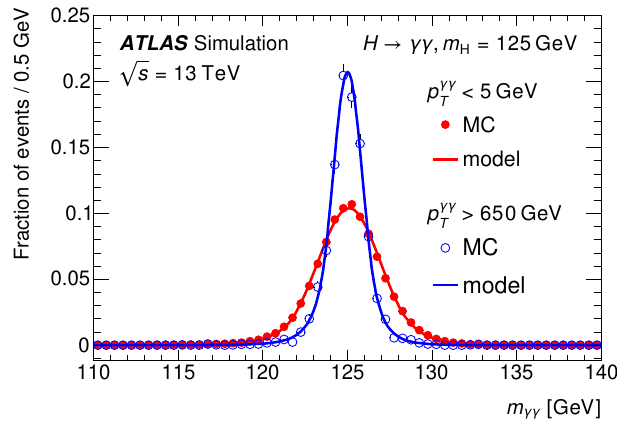
bins considered. The two fitted models Figure 2. Signal m γγ model in the lowest and highest p γγ T (solid curves) are compared with the m distributions of the signal MC events in the lowest (filled γγ markers) and highest (open markers) p γγ bins. The resolution, evaluated as half the width of the T narrowest interval containing 68.3% of the simulated events, varies between 1.0 GeV and 1.9